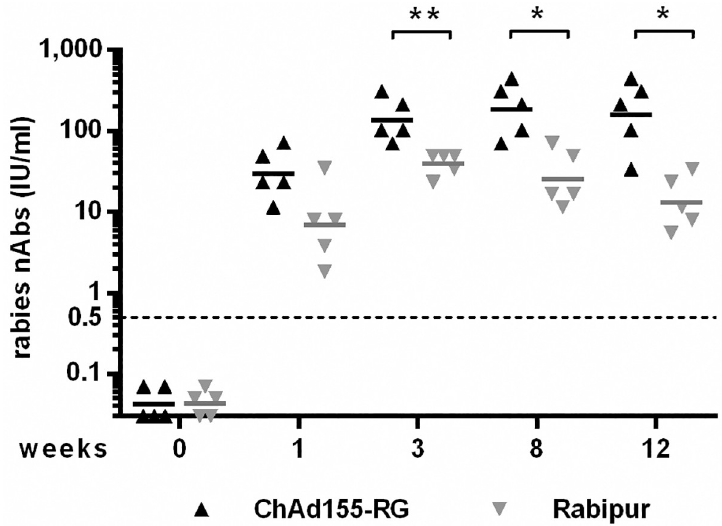
Fig 4. Kinetics of VNA induction after a single dose in rabbits. Groups of five rabbits each received a single intramuscular immunization with 5x10 10 vp of ChAd155-RG or 500 μ l RABIPUR (half human dose). Rabbits were bled on time of vaccination (week 0) and on weeks 1, 3, 8 and 12 post vaccination. Serum from each animal was tested for detection of rabies VNA by FAVN, and titers expressed as IU/ml. The horizontal lines represent geometric mean titers. A two-way analysis of variance was applied having as sources of variation “treatment” (the two vaccines), “time” (subsequent weeks of observation) and as dependent variable “antibody titer”. Statistically significant effect was found for both sources of variation and their interaction (treatment p = 0.0025, F (1, 8) = 18,78; time p = 0.011, F (2,043, 16,34) = 5,969; time x treatment p = 0.0118, F (4, 32) = 3,832).